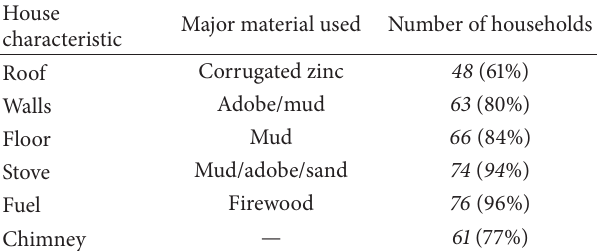
Table 2: Summary of common house construction materials. Total 𝑁 = 79